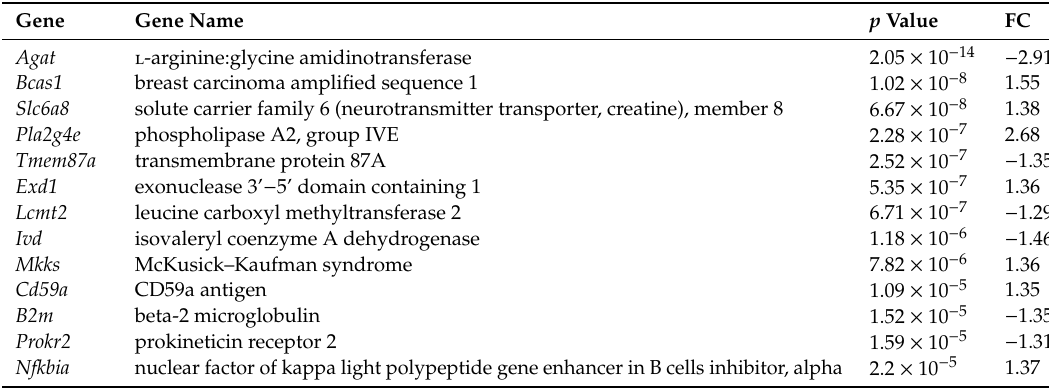
Table 3. Di ff erentially expressed genes between WT and AGAT - / - hArg mice in brain tissue. False discovery rate ≤ 0.05. Abbreviations: FC, fold